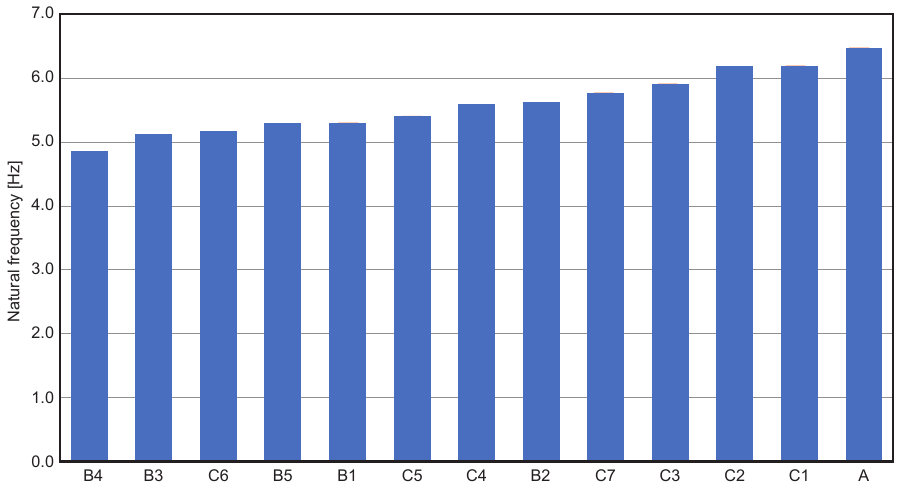
Figure 5. Natural frequencies of the first mode of vibration for the different configurations (ranked from lowest to